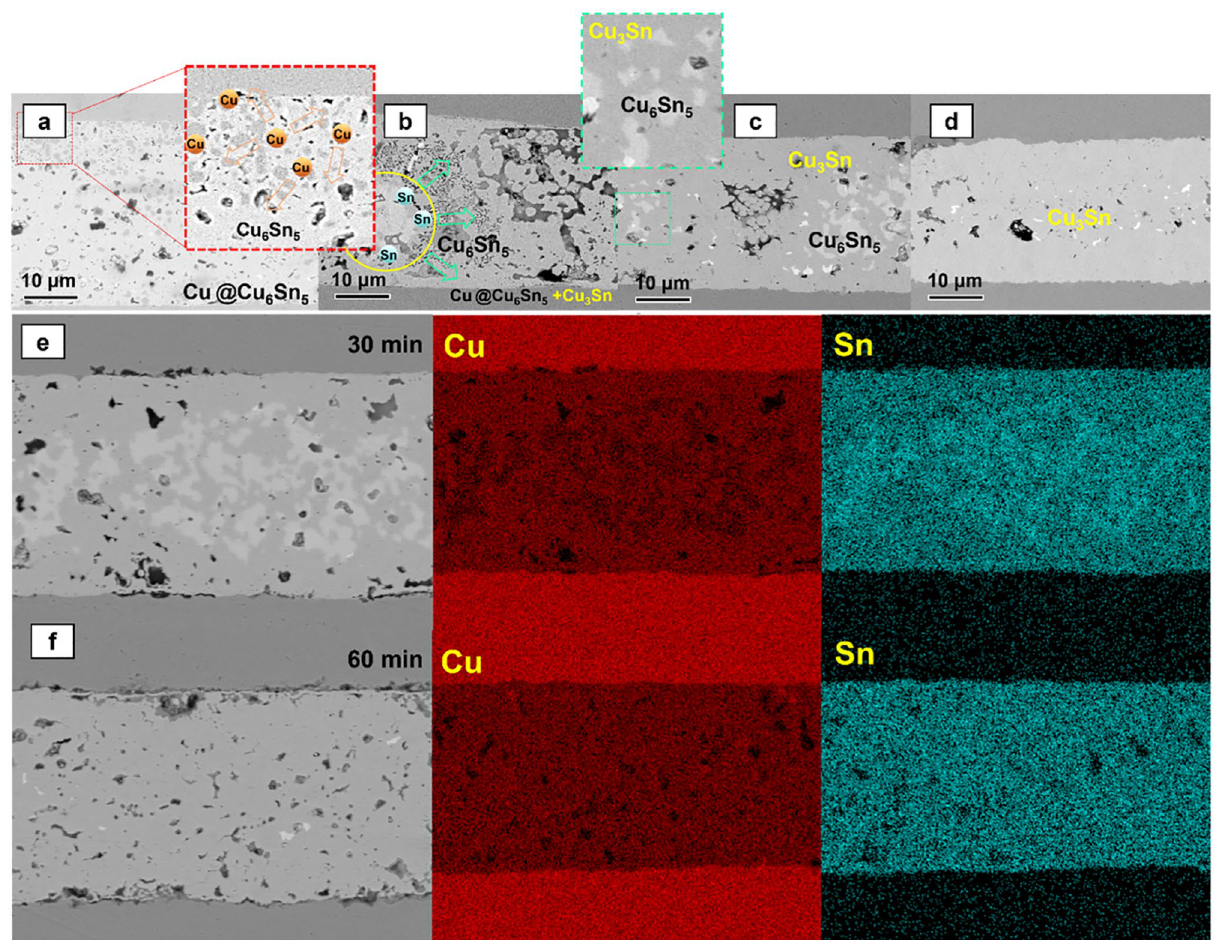
Figure 5. The change in joint tissue during reflow at 280 °C (10 MPa) ( a ) 5 min, ( b ) 15 min, ( c ) 30 min, ( d ) 60 min, ( e ) EDX mapping result of joint reflowing 30 min at 280 °C, ( f ) EDX mapping result of joint reflowing 60 min at 280